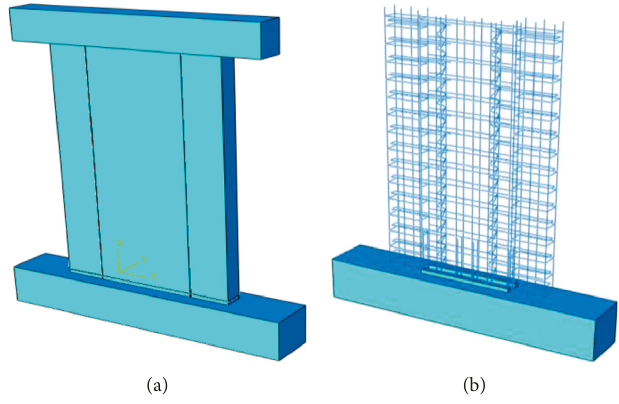
Figure 6: Finite element model of W2.